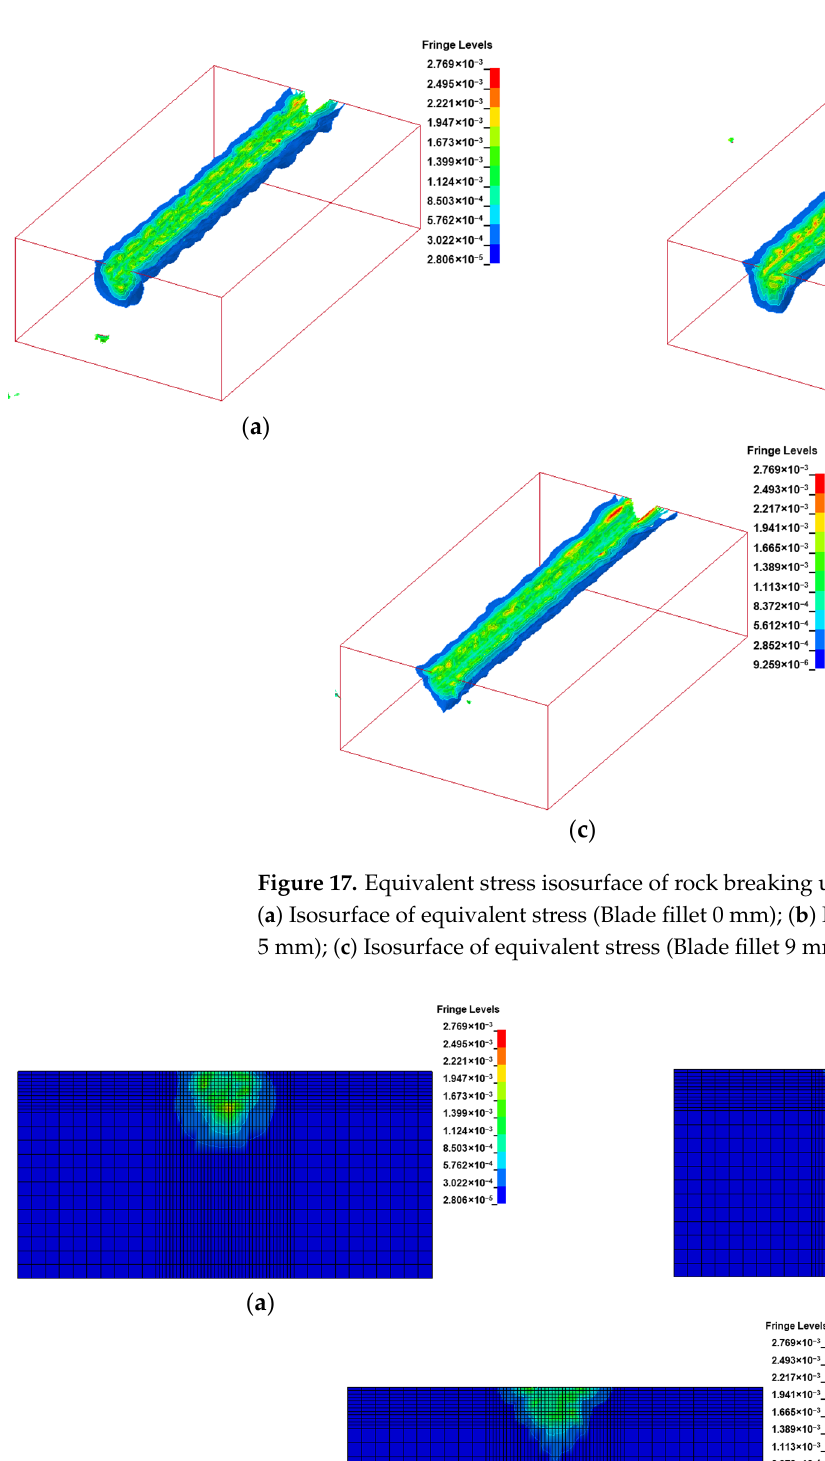
( d ) Figure 16. The contact force of BW 22mm disc cutter with different blade fillets. ( a ) Normal force; ( b ) Rolling force; ( c ) Range and STD of normal force; ( d ) Range and STD of rolling force.